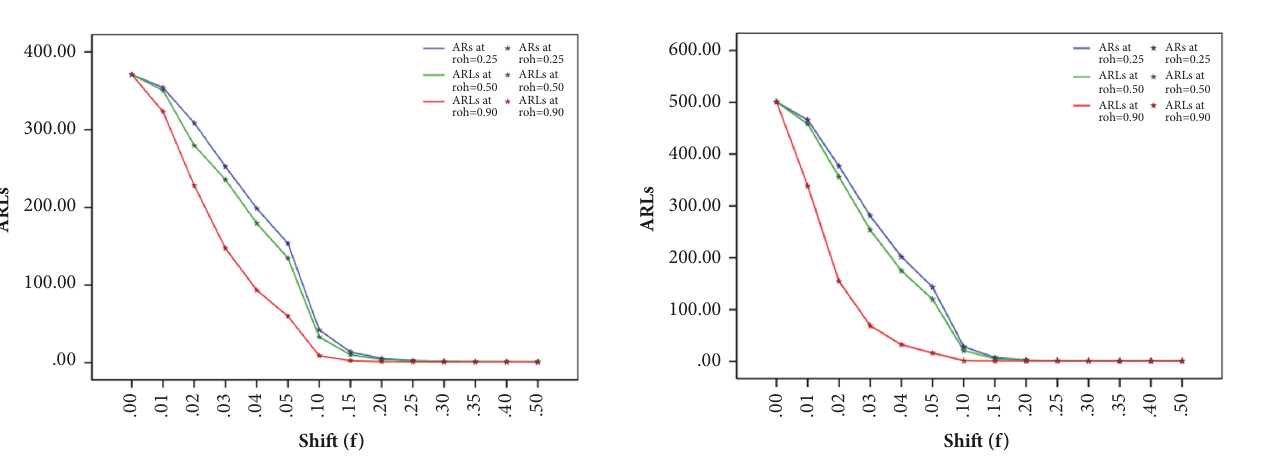
Figure 6: ARLs for proposed repetitive EWMA-RSS control chart using Bahl and Tuteja (1991) ratio estimator, when 𝑟 𝑜 = 370 at 𝜆 = 0.3.